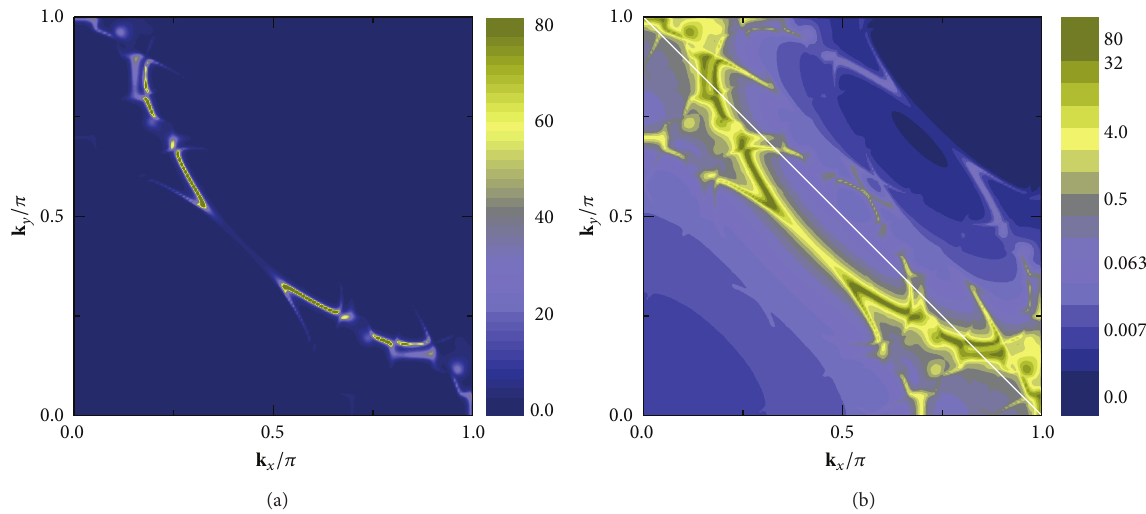
Figure 4: (a) The intensity plot of the zero energy spectral function 𝐴( k ,𝜔 = 0) with Δ 0 = 0 and 𝑉 = 0.1 . (b) The same as (a) while the logarithmic scale is